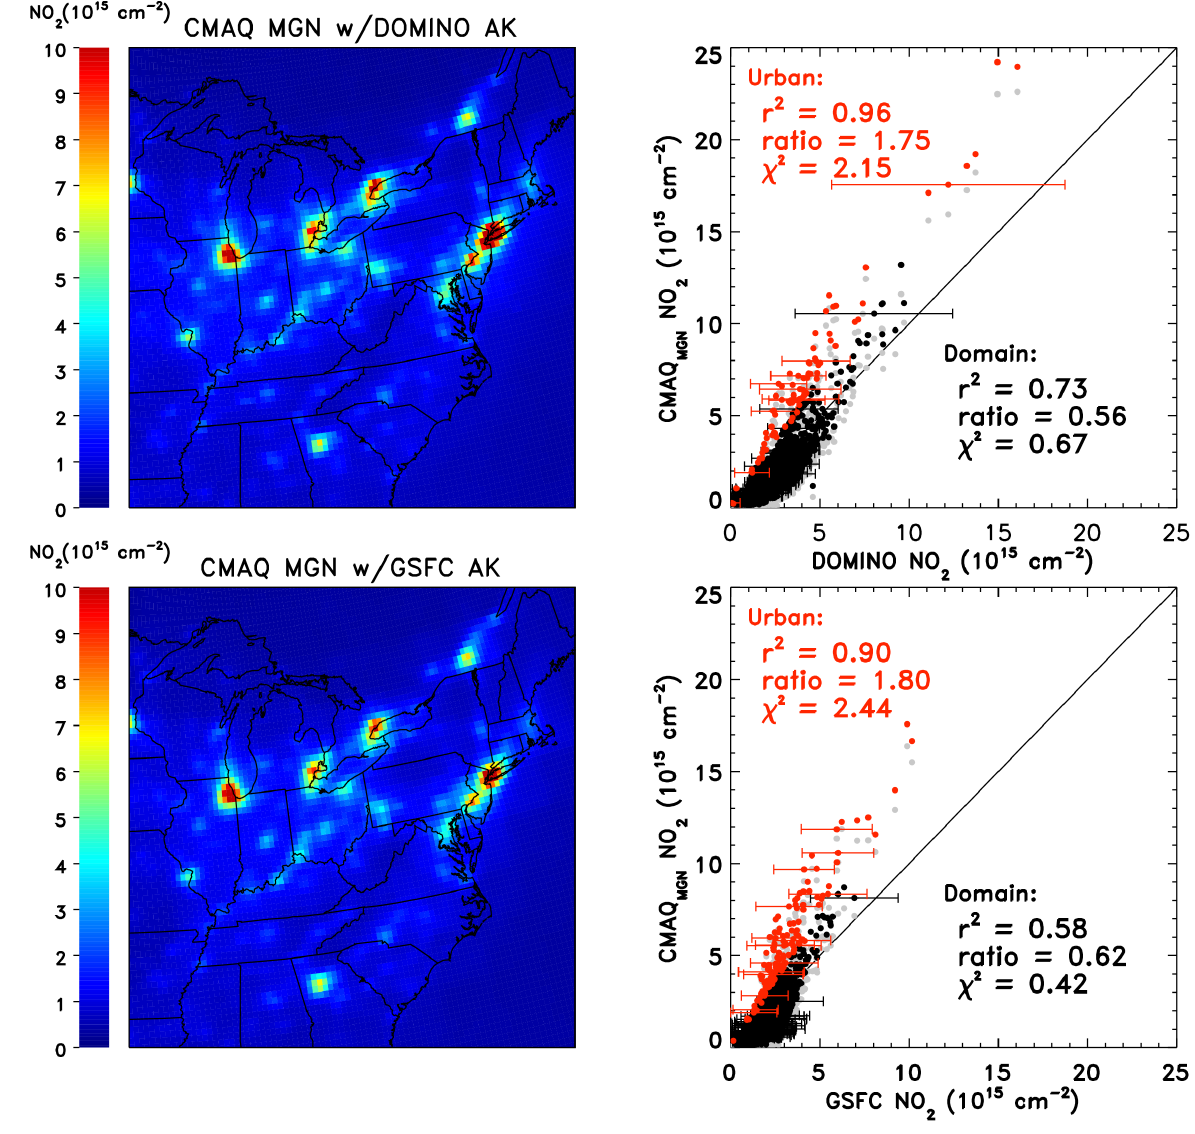
Figure 7. Same as Fig. 2 except model results include updated biogenic emissions from MEGANv2.10 (CMAQ MGN ). Gray points on the scatter plots represent the results shown in Fig. 2 (right